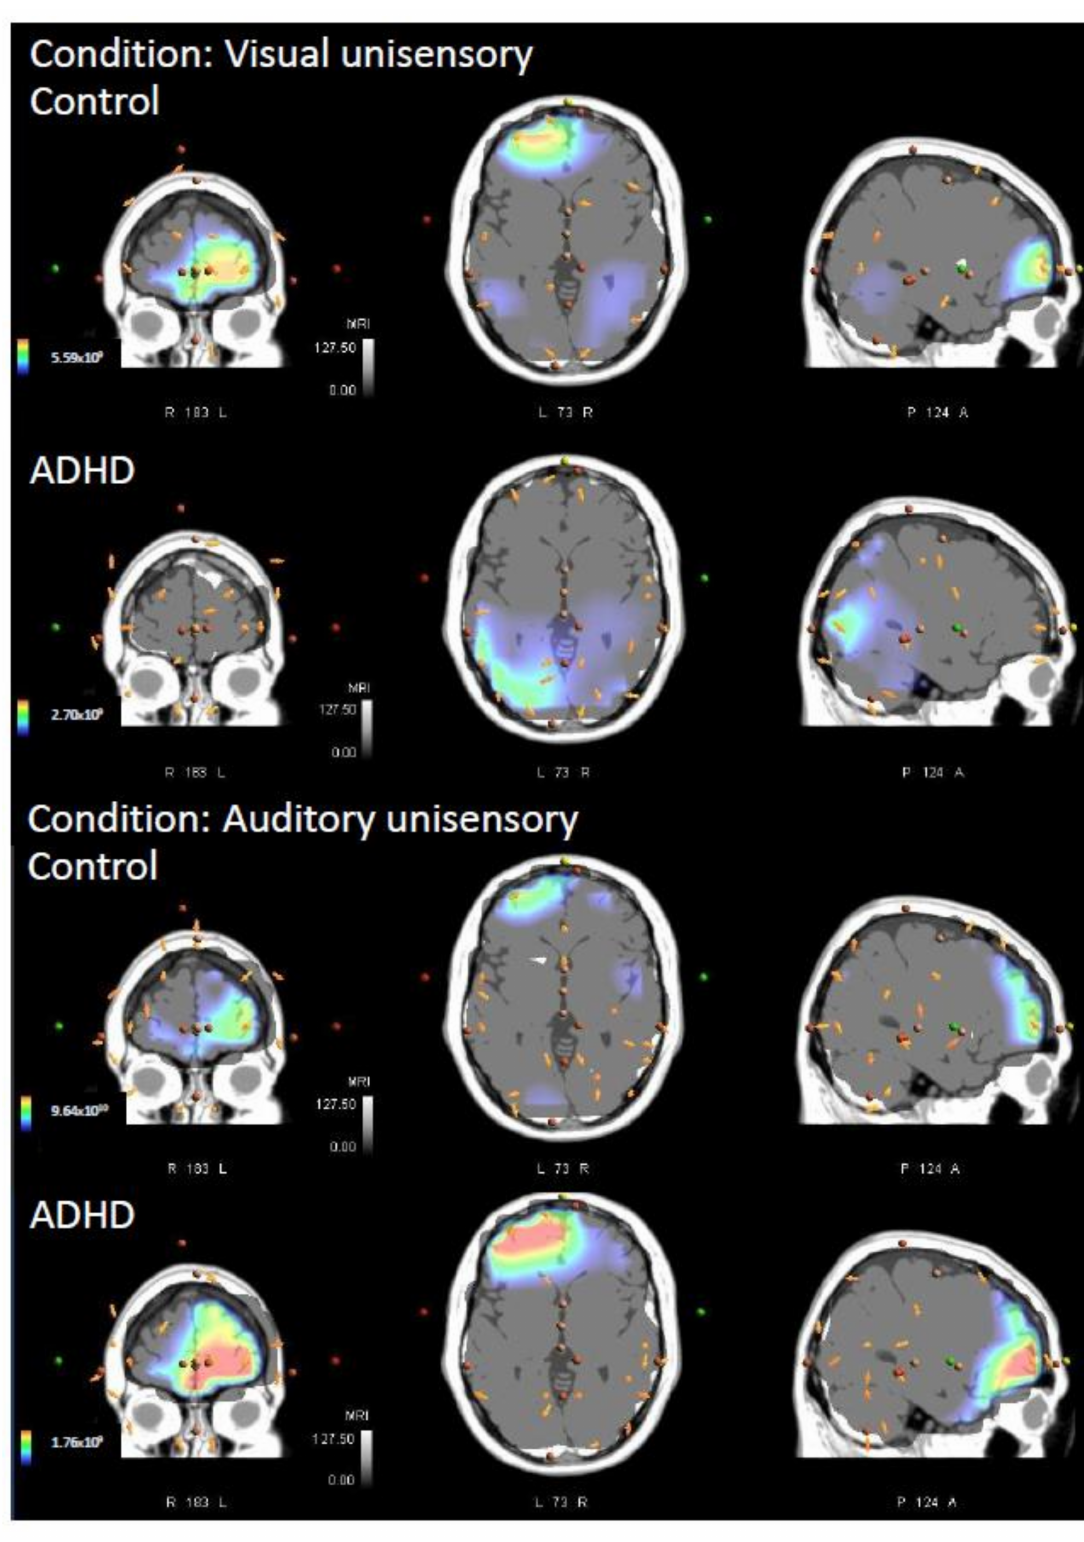
Figure 7. Average sources of neural activity for both unisensory conditions (top: visual, 165 post stimulus onset; bottom: auditory, 96 ms post stimulus onset) and for each group (ADHD and Control). Cross- sectional areas from left to right are coronal ( left ), transverse ( middle ), and the sagittal plane ( right